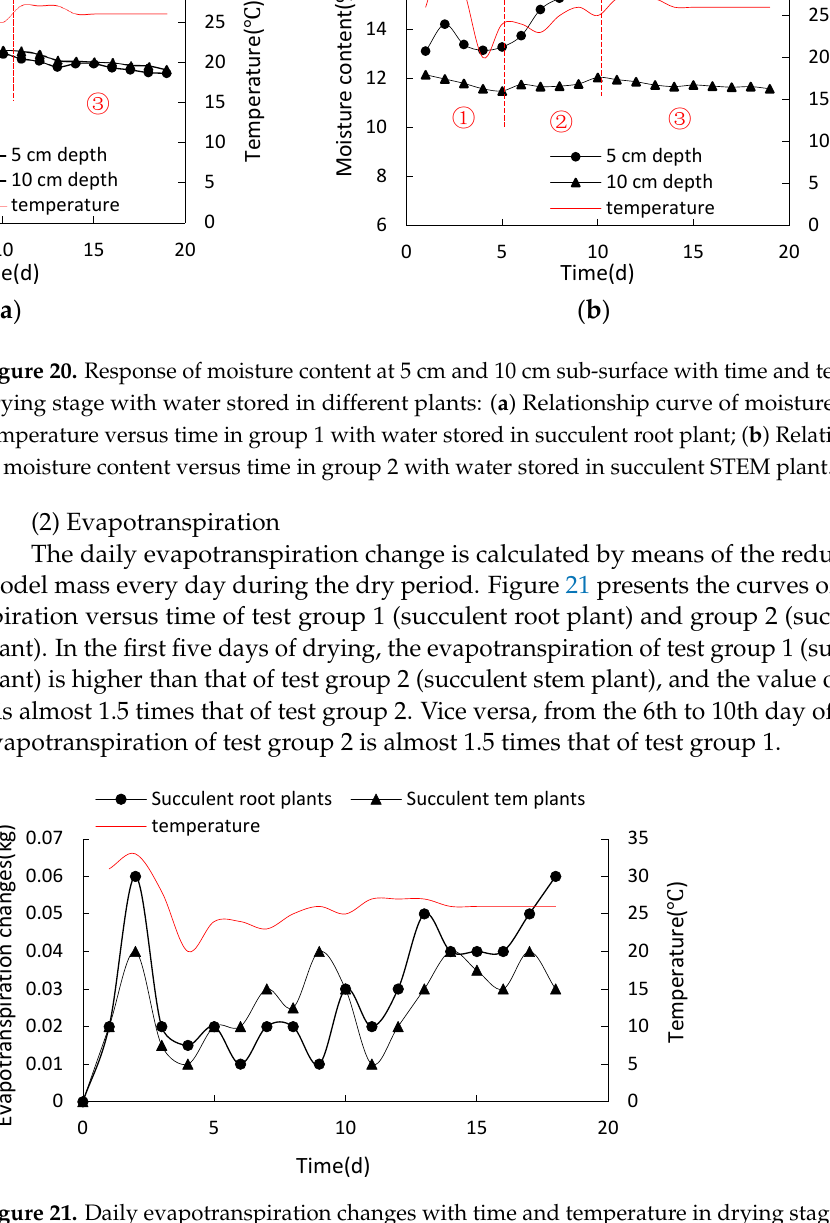
Figure 21. Daily evapotranspiration changes with time and temperature in drying stage for the tests with water stored only in succulent root plants or only in succulent stem plants.